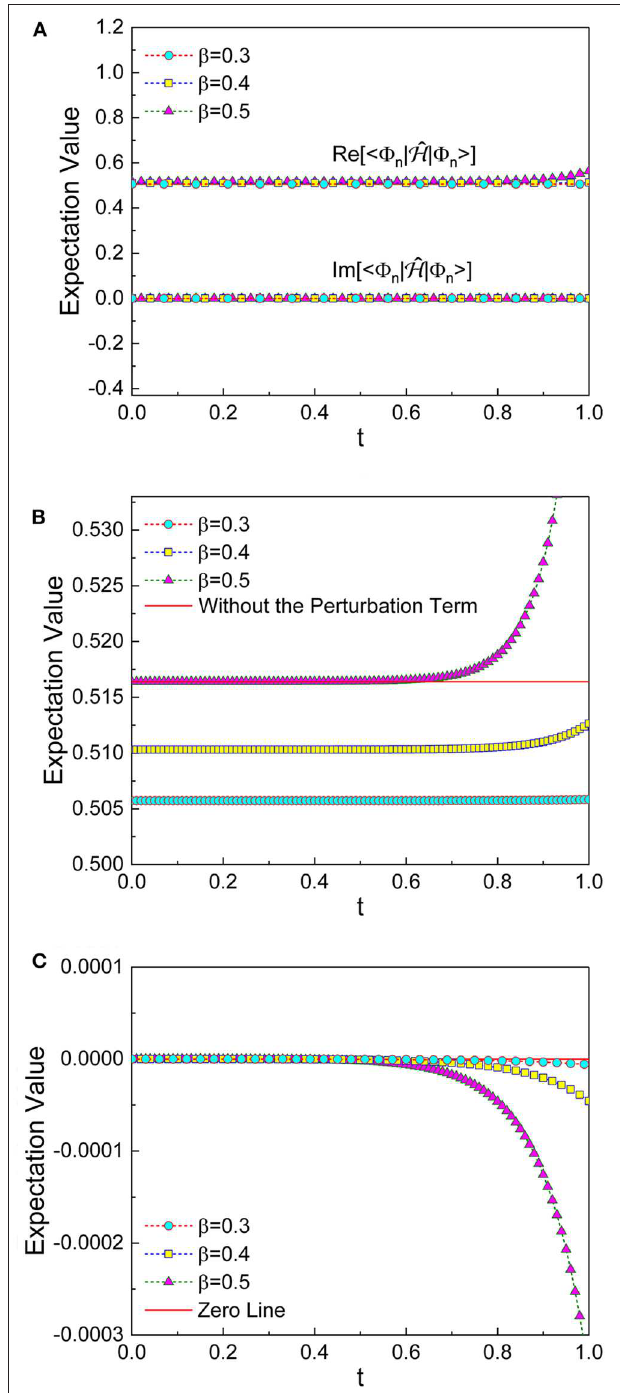
FIGURE 2 | (A) The time evolutions of the real and the imaginary parts of the expectation values, Equation (35), for the system described in Equations h (36)–(38), for three different values of β . The parameters are chosen as 1, = ¯ c 2 b ω 0 1, m 0 1, n 0, c 1 1, ǫ 0.0001, and a 1. (B) = = = = = = = = Enlargement of the real parts in (A) . The reference solid red line is the expectation value of the Hamiltonian without the perturbation term, given in Equation (17), under the choice of β 0.5. (C) Enlargement of the imaginary = parts in (A) . The reference solid red line indicates zero of the vertical axis.